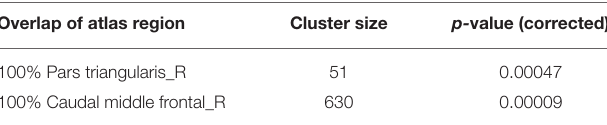
TABLE 6 | Abnormal structure located by cluster in the CA group assessed by surface-based morphology analysis. Overlap of atlas region